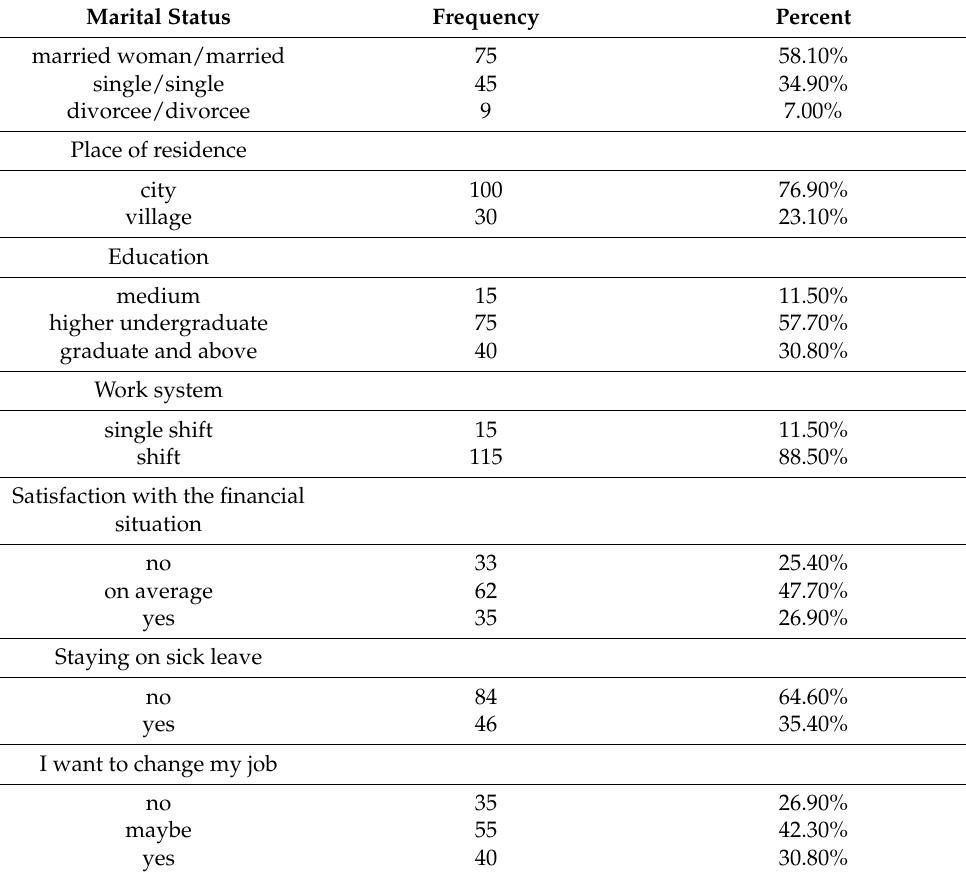
Table 1. Socio-demographic characteristics of the study